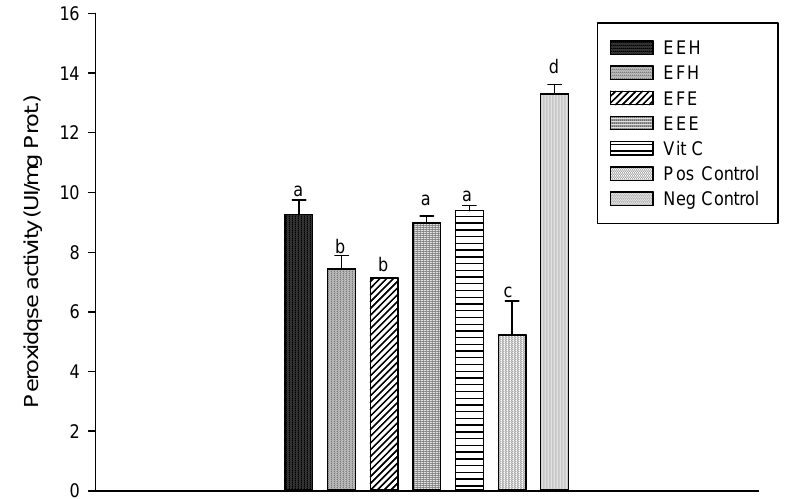
Figure 11. Protective properties of plant extracts: peroxidase activity. Values are expressed as mean ± SD of three replicates. In the same column the values labeled with different letters differ significantly at p < 0.05. EEE: H. zenkeri ( bark) ethanolic extract; EFE: H. zenkeri (leaves) ethanolic extract; EEH: H. zenkeri (bark) hydro-ethanolic extract; EFH: H. zenkeri (leaves) hydro-ethanolic extract; Vit C: Vitamin C. Pos Control: oxidant (positive) control. Neg Control: Normal (negative)